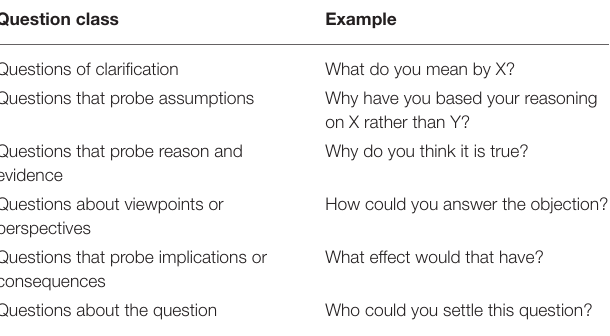
TABLE 1 | Six classes of critical questions proposed by Paul and Elder